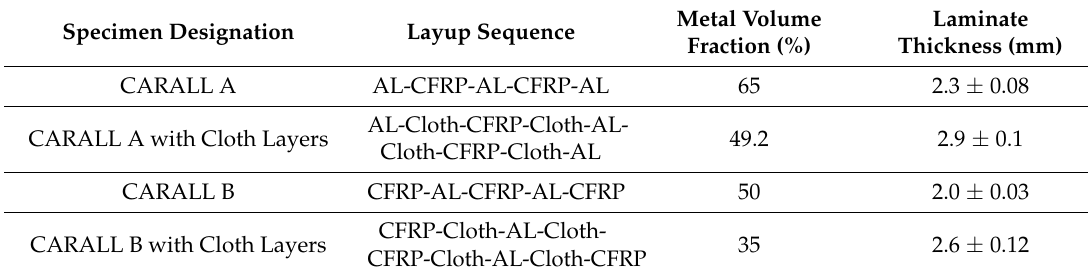
Table 4. Specimen notations and layup sequence for CARALL fiber metal laminates.